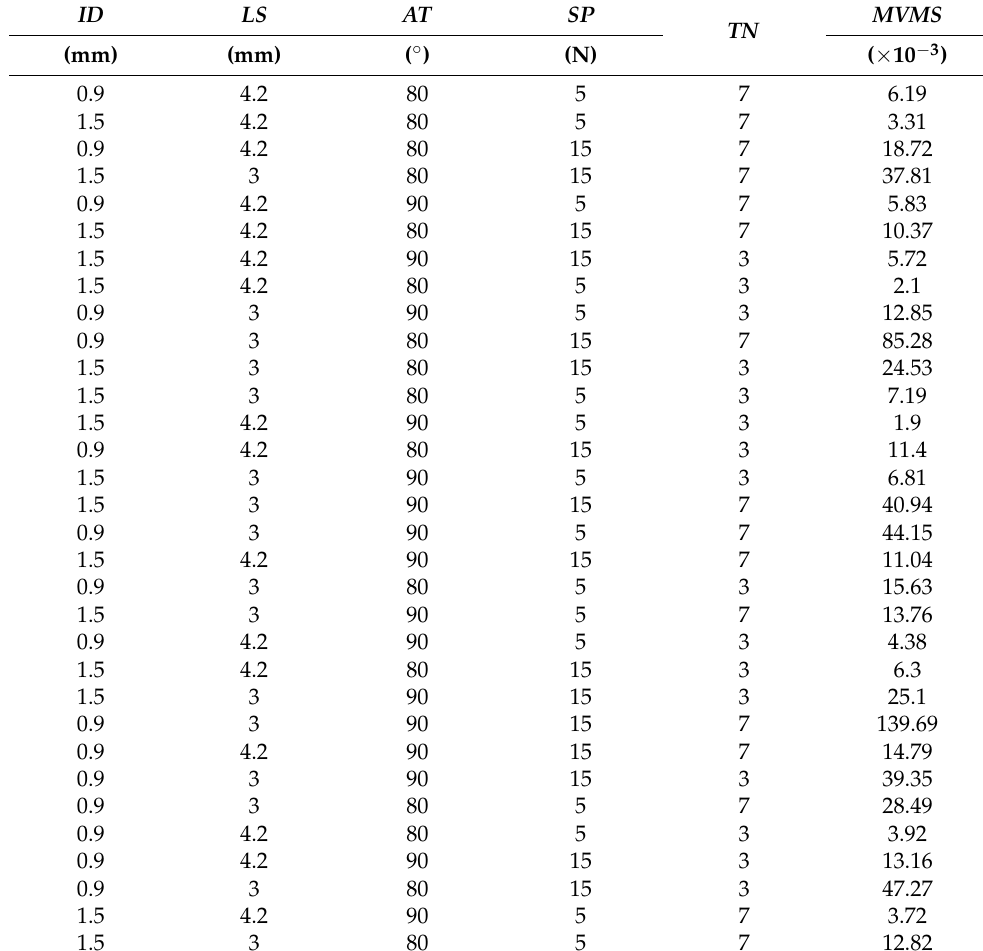
Table 3. Full factorial design of 2 levels and 5 factors for mini screw.